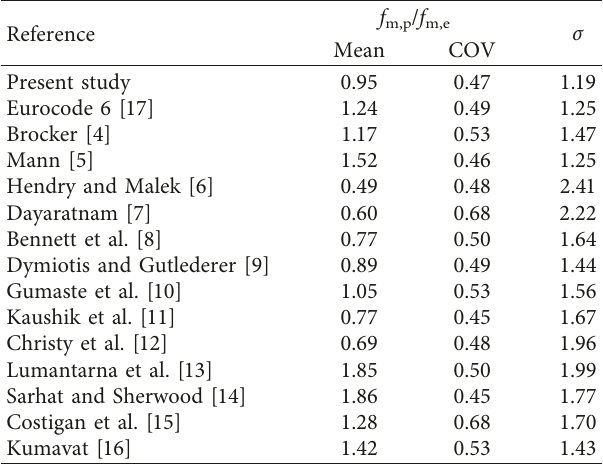
Figure 5: Compression of predicted compressive strength of the masonry prisms with experimental data from the literature: (a) present study, (b) Eurocode [17], (c) Brocker [4], (d) Mann [5], (e) Hendry and Malek [6], Dayaratnam [7], (g) Bennett et al. [8], (h) Dymiotis and Gutlederer [9], (i) Gumaste et al. [10], (j) Kaushik et al. [11], (k) Christy et al. [12], (l) Lumantarna et al. [13], (m) Sarhat and Sherwood [14], (n) Costigan et al. [15], and (o) Kumavat Table 10: Comparison of past experimental data with analytical predication.